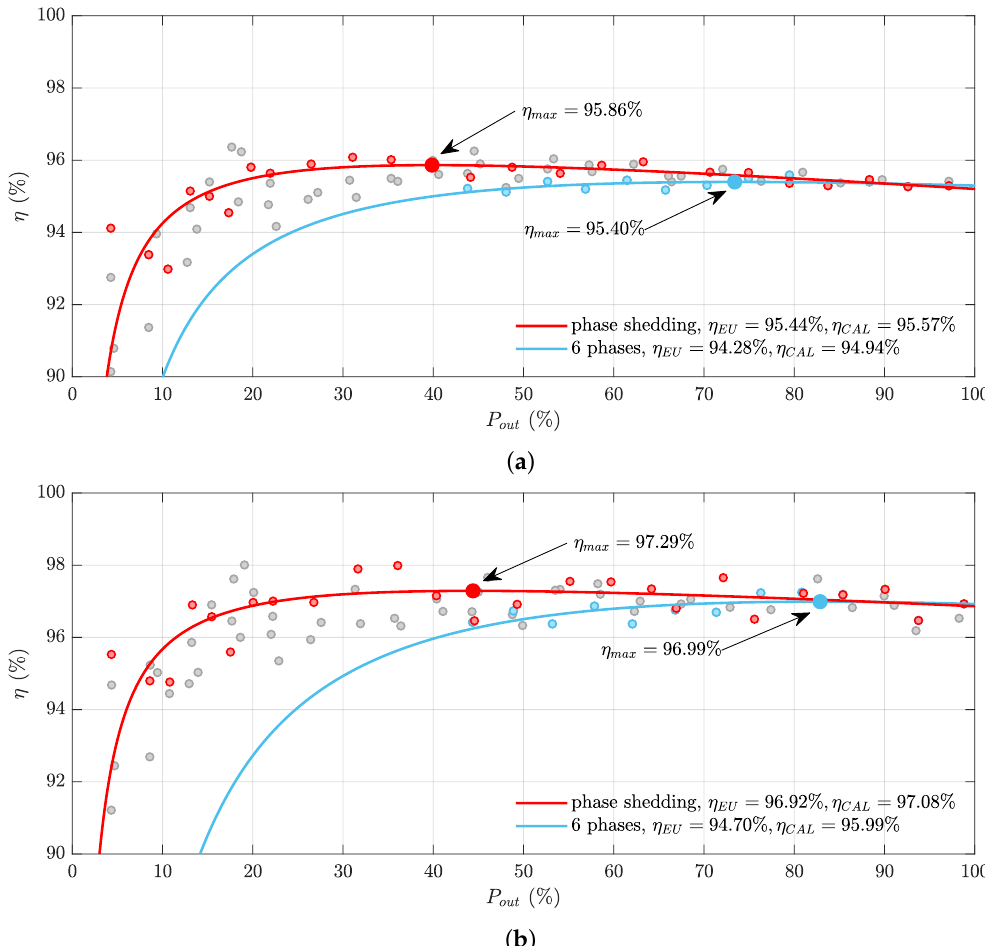
Figure 17. Efficiency comparing interpolated phase shedding and six phases of non-synchronous operation ( a ) and synchronous operation ( b ). Experimental data are represented with colored circles, and continuous traces represent the interpolation.